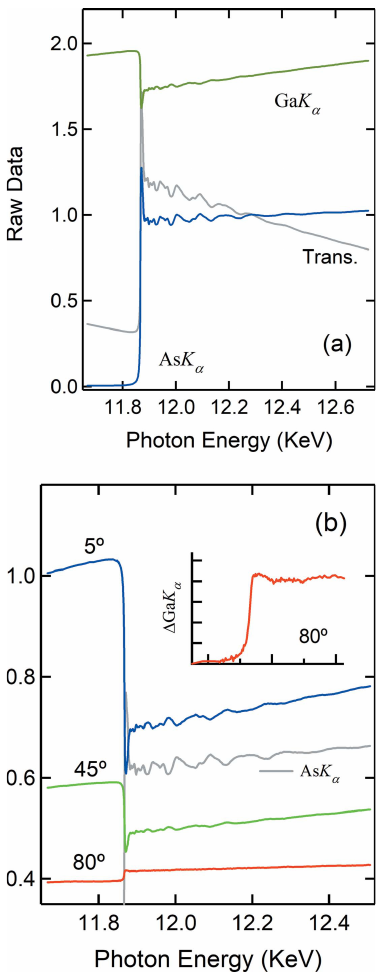
Figure 4 ( a ) The (cid:10) factor around the In and As K -edges as functions of (cid:5) and (cid:6) (see details in Table S1 to S2). ( b ) The (cid:5) -dependences of the (cid:10) effects on the EXAFS amplitudes (Calc.) and of As K (cid:5) /Ga K (cid:5) for the GaAs wafer (Exp.). The full red circle is the result from As K (cid:5) . The oval trace indicates the region where the (cid:10) effect is small but the SA effect is large. Insert: experimental geometry.